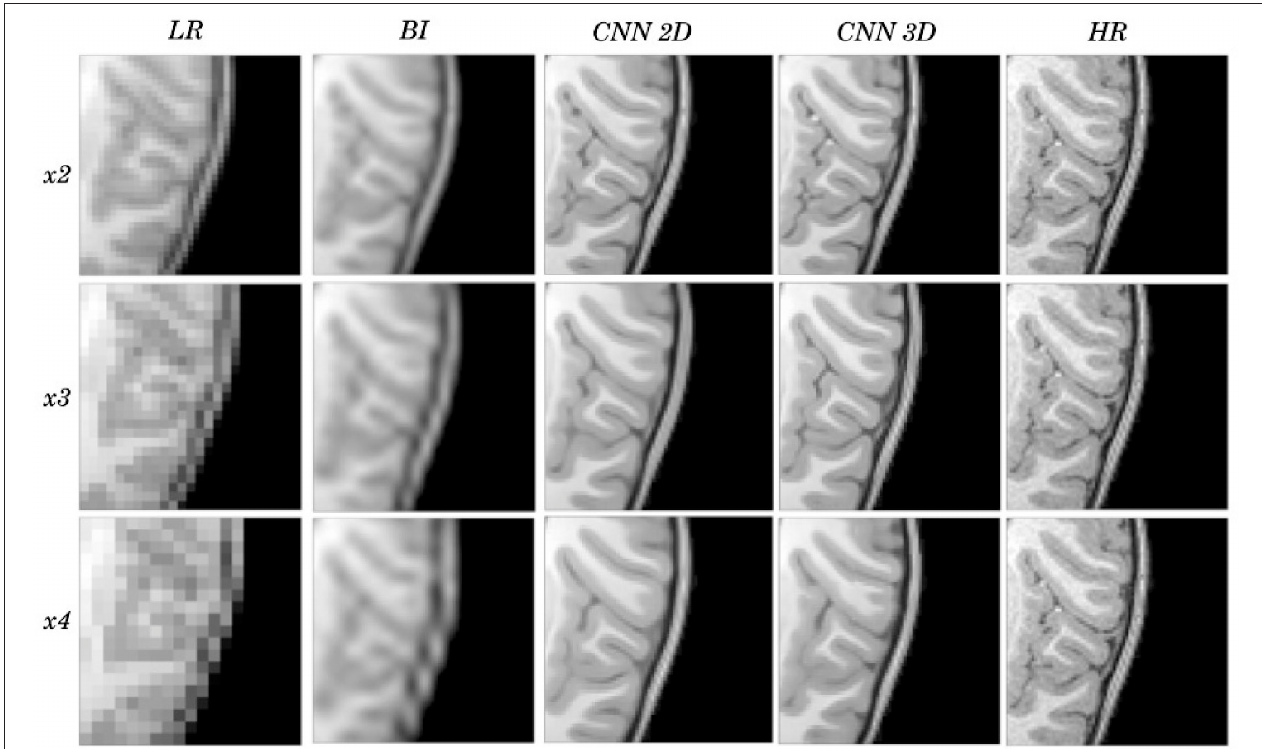
FIGURE 3 | Detail on the images of Figure 2